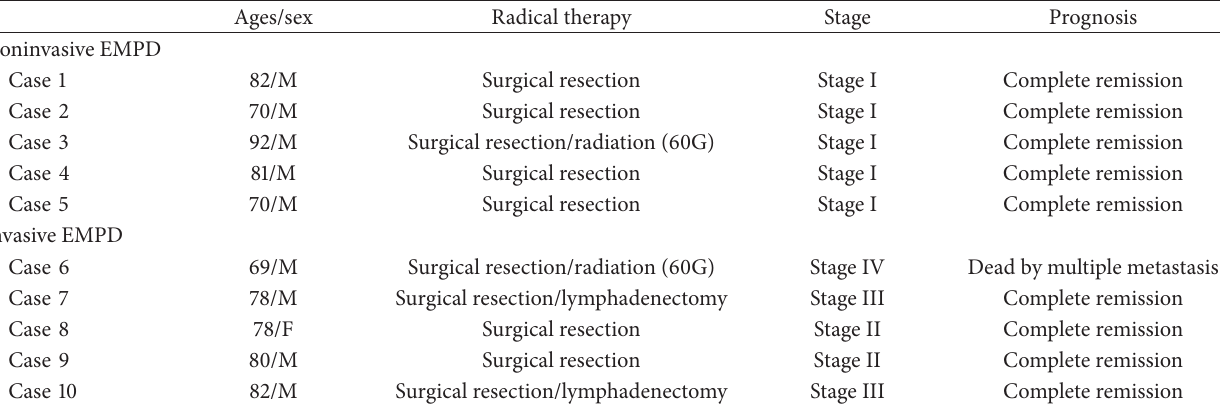
Table 1: Summary for 10 cases of invasive or noninvasive EMPD. We summarized the treatment, clinical stage, and prognosis of invasive or noninvasive EMPD.